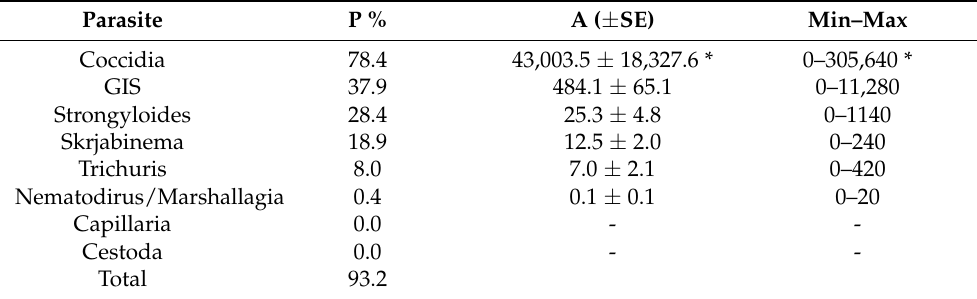
Table 1. Epidemiological indexes of gastrointestinal parasites in the study area (n = 264).